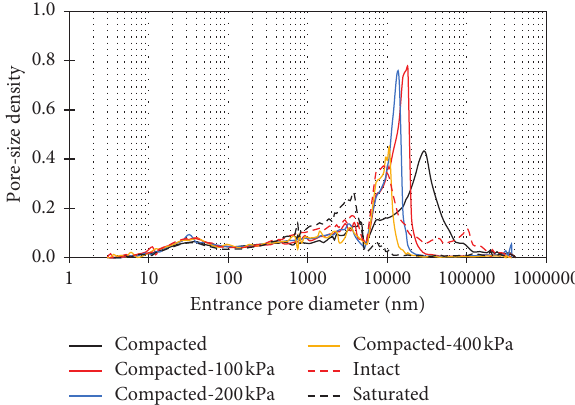
Figure 9: PSDs of compacted loess specimens consolidated to various confining